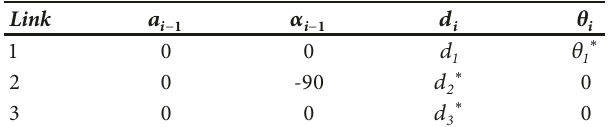
Figure 1: The position of the coordinate systems on each of the joints. Table 1: The Denavit-Hartenberg parameters with regard to each